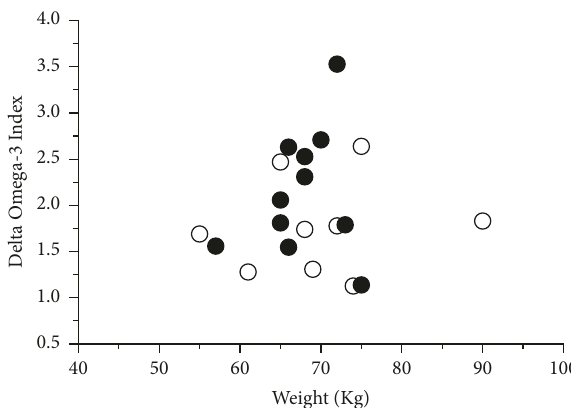
Figure 3: Relation of Omega-3 Index with body weight. There is a low correlation of the O3Ix distribution related to body weight in the population of this study.